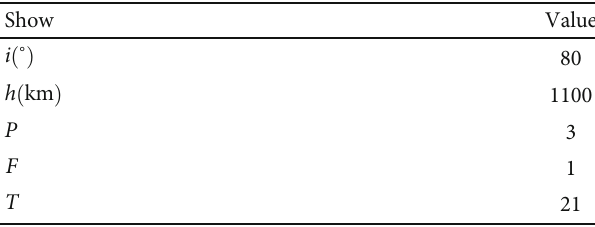
Figure 1: Brush lines of 9 satellites in COF ( h = 650km , i = 60 deg , ε > 10 deg ).